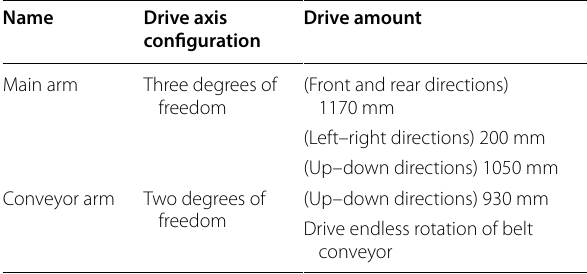
Table 3 Linear motion-type depalletizing robot drive axis configuration and drive